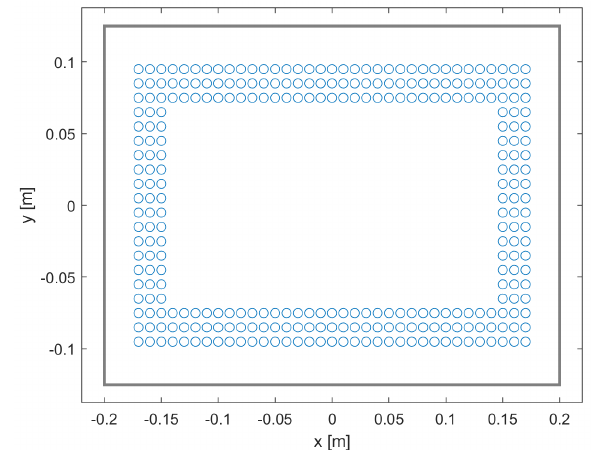
Figure 4. Candidate (blue circles) bar positions inside the dielectric rectangle (grey line). Bars are numbered from bottom left to top